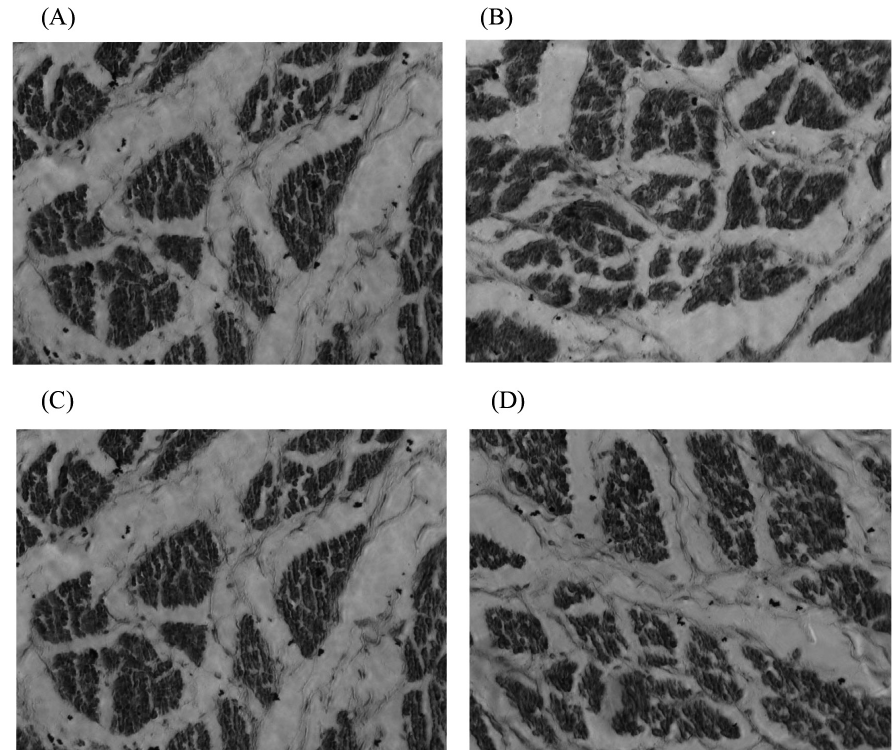
Figure 3. The paraffin sections of breast muscle fiber in the 15th day embryo in 400× AMG EVOS microscope. (A) 100% energy group; (B) 80% en - ergy group; (C) 70% energy group; (D) 50% energy group. Breast muscles were dehydrated in alcohol and finally embedded in paraffin wax. Trans - verse sections 10 mm thick were cut, stained with haematoxylin and eosin, and mounted in the usual way. Subsequently, 8 photomicrographs for fibre diameter measurements were taken using the AMG EVOS microscope's particular morphometric function. In each muscle sample, more than fifty diameters were measured, and the densities were calculated. Compared with the 100% energy group, in general, the diameter and den - sity of the embryonic breast muscle fibres in each energy-restricted group showed a decreasing